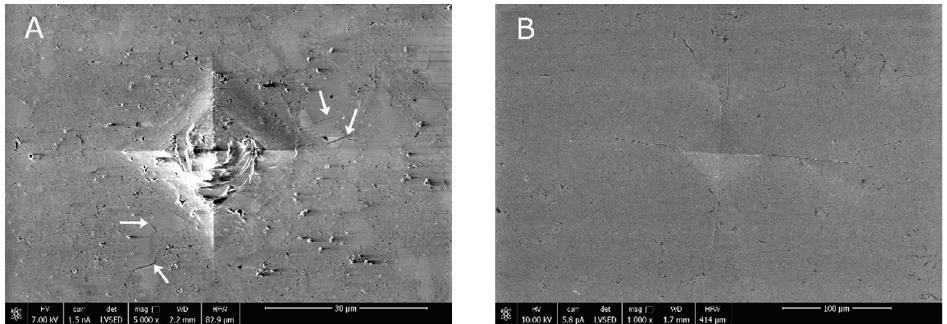
Figure 7. SEM micrograph of Vickers indent applied to the sample surface of ( A ) low (7.4 mol%) and ( B ) high (11.5 mol%) MgO content.